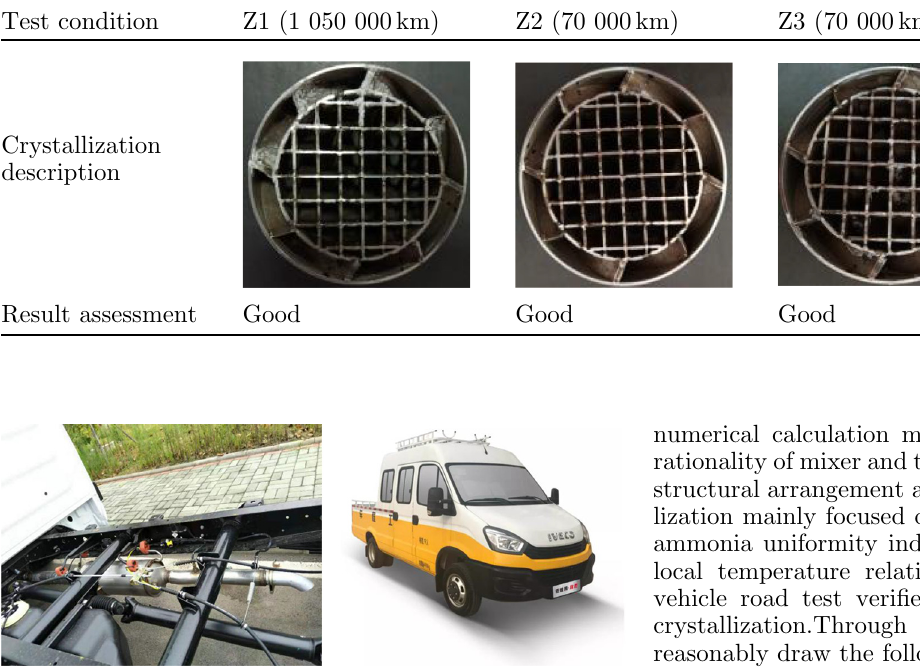
Table 9. Crystallization status of the mixer after the vehicle durability test. Test